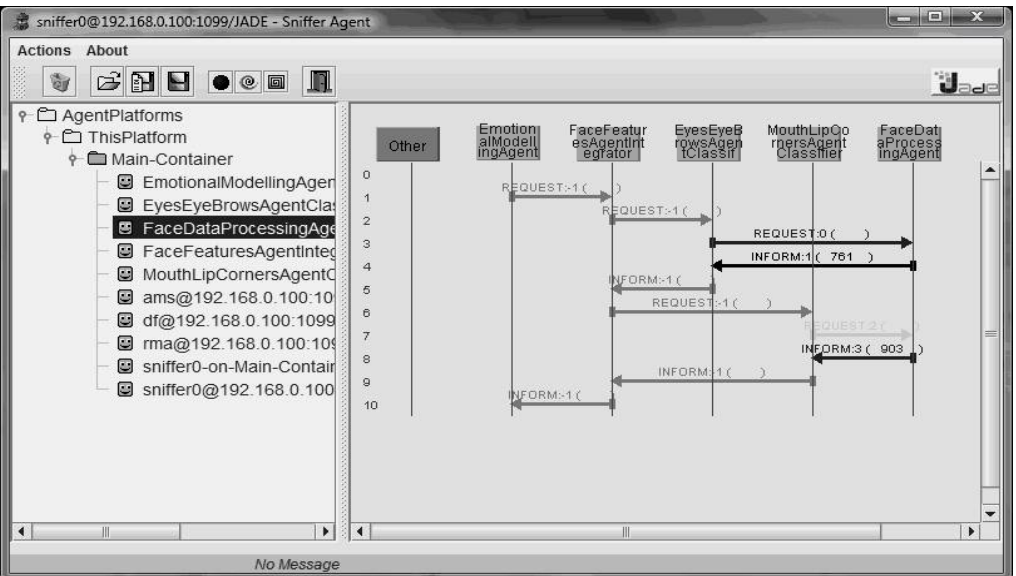
Fig. 8. Messages sent among agents and sequence of these messages using Sniffer